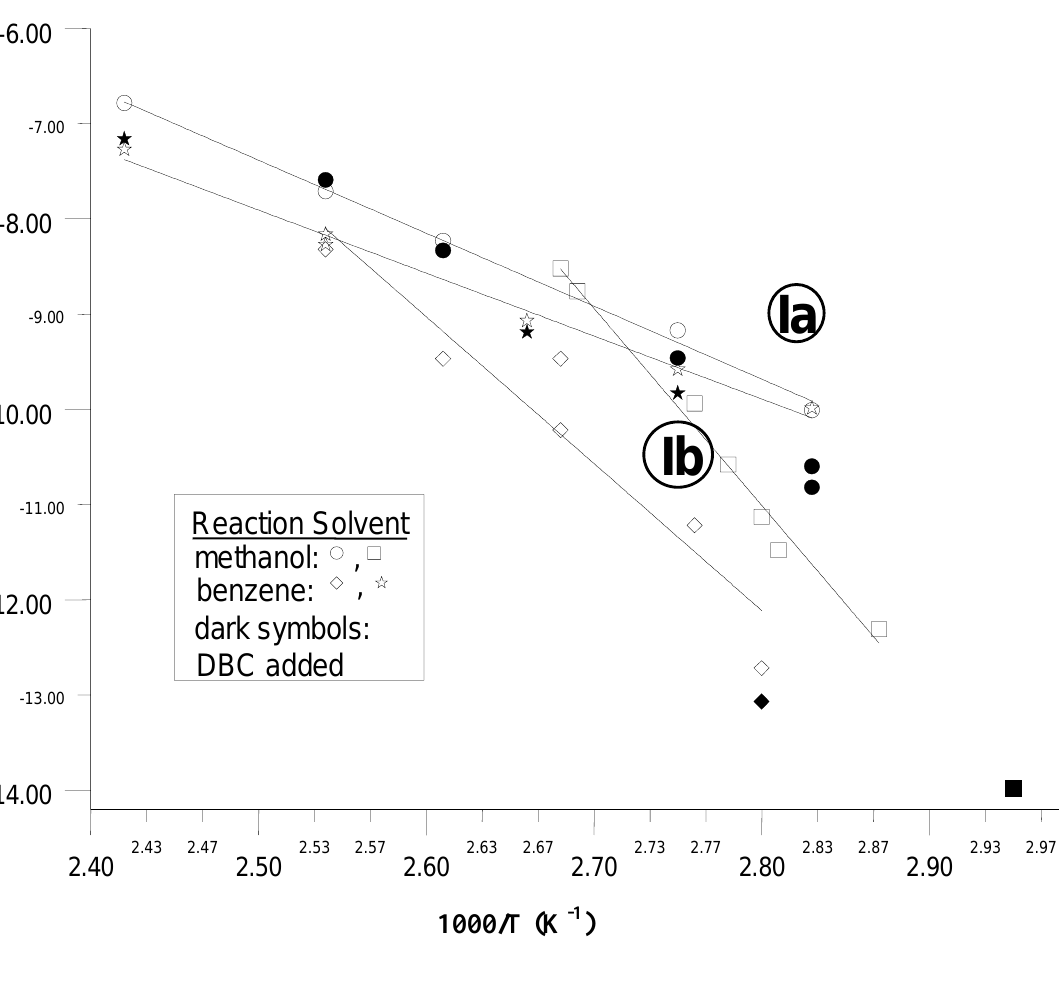
Figure 2 . Arrhenius Equation Plots for the Thermolysis of Trioxanes Ia and Ib in Solution. Ln k (s -1